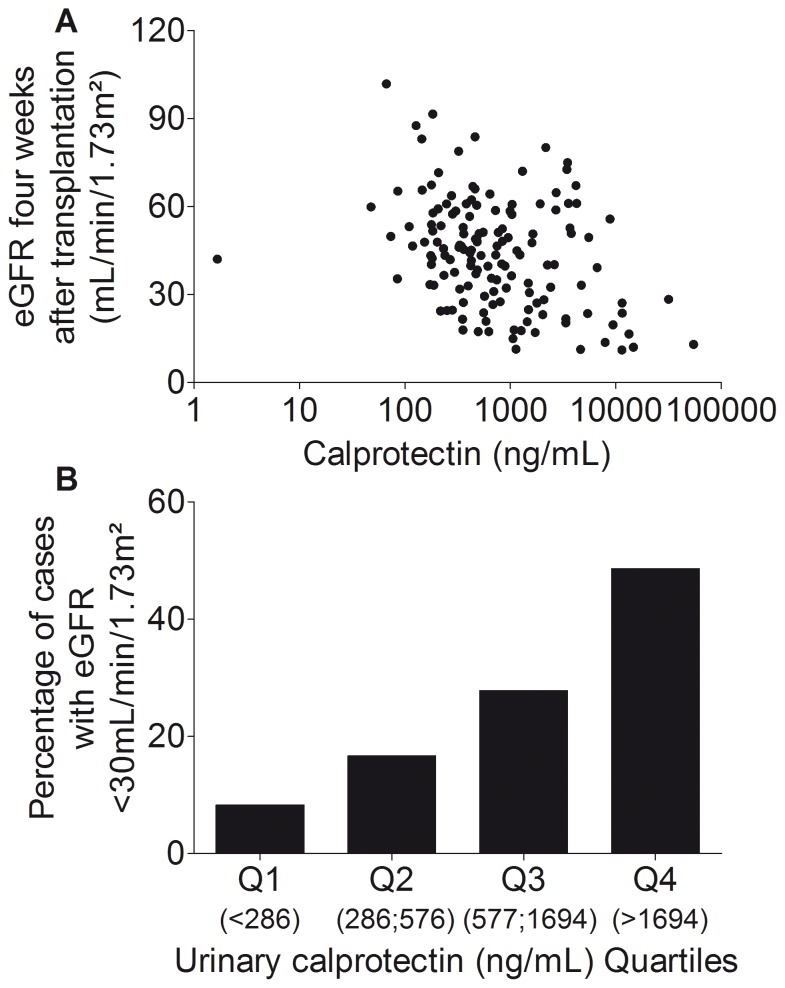
Association of urinary calprotectin with estimated glomerular filtration rate.
A. Dot plot depicting the significant association of urinary calprotectin levels (log scale) with estimated glomerular filtration rate (eGFR) four weeks after transplantation. Spearman r = −0.33; P<0.001. B. Percentage of cases with estimated glomerular filtration rate (eGFR) after 4 weeks in the lowest quartile (i.e., less than 30 mL/min/1.73 m2) is shown. Bar graph shows percentages of cases from the contingency table, therefore there are no error bars. Chi-square derived from the contingency table was 17.10; P<0.001.